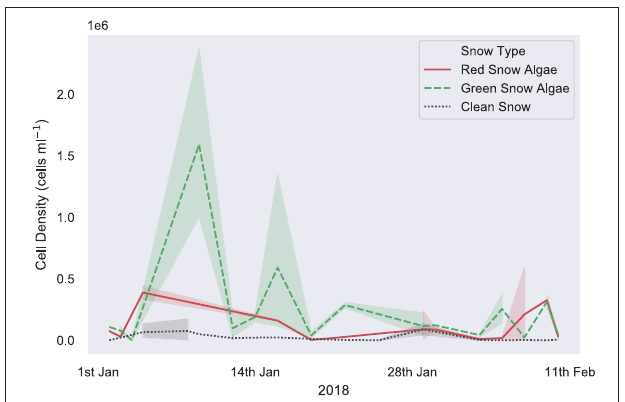
FIGURE 7 | In situ bloom area measurements. In situ measurements of visible bloom area, recorded with a Trimble dGPS throughout the 2018 field season in the Ryder Bay area. Blooms recorded are from Rothera Point, Anchorage Island, Lagoon Island, and Léonie Island.